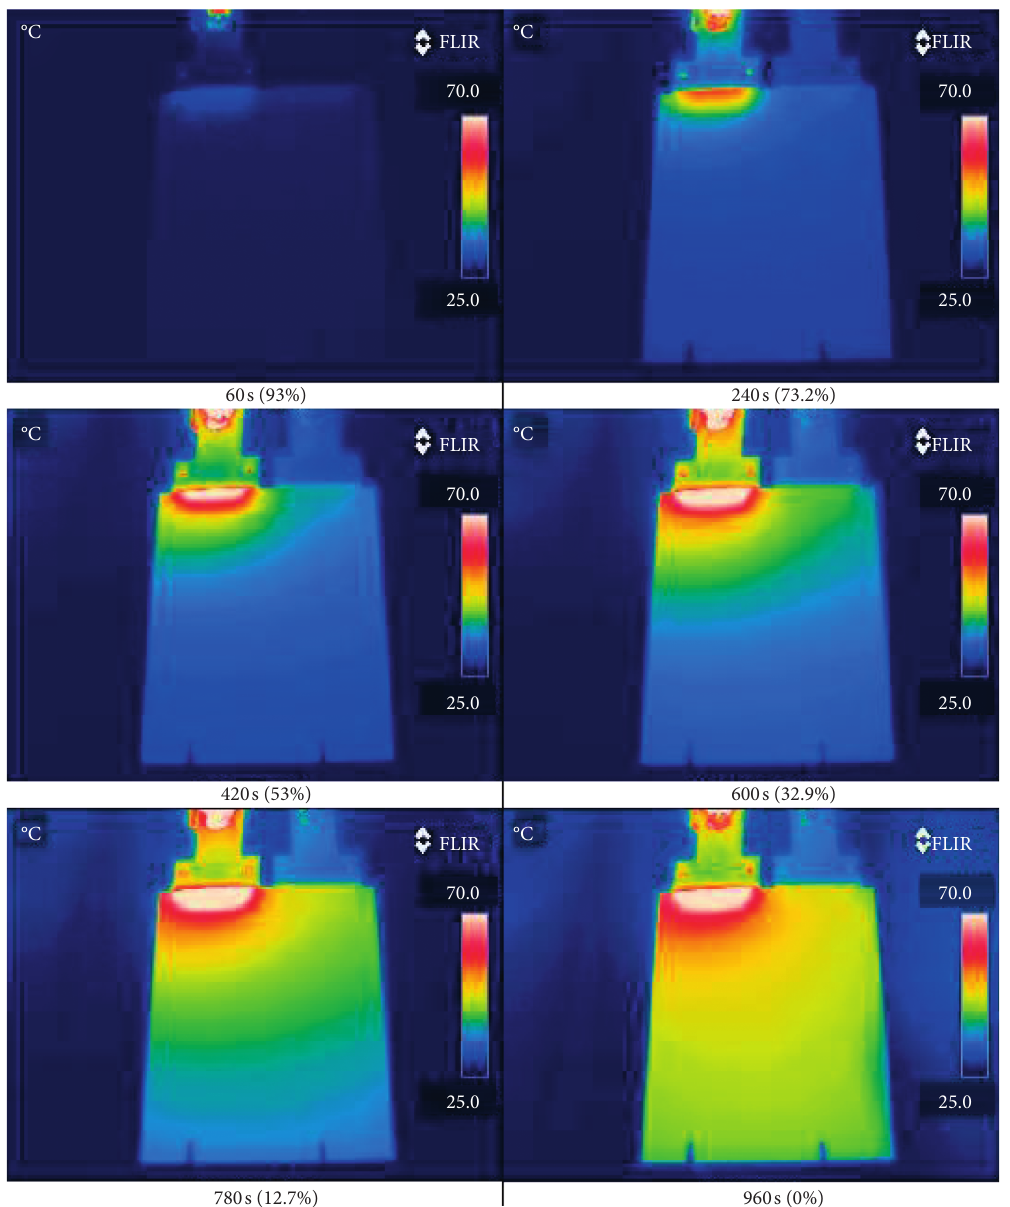
Figure 3: Thermal mapping of the battery